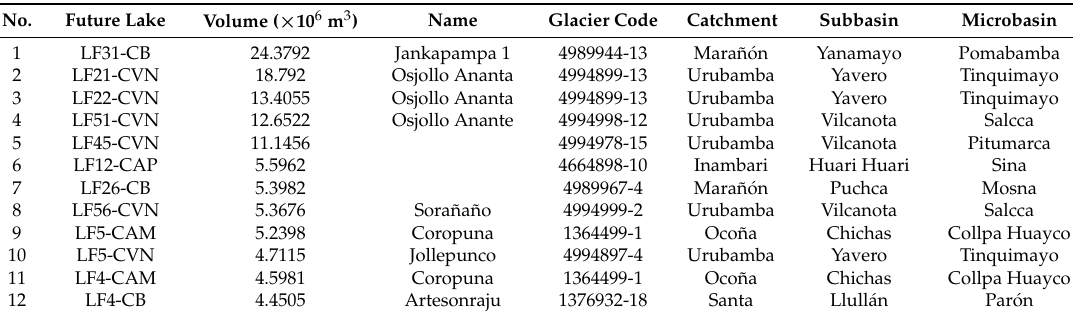
Table 2. Possible future lakes with volumes >4 × 10 6 m 3